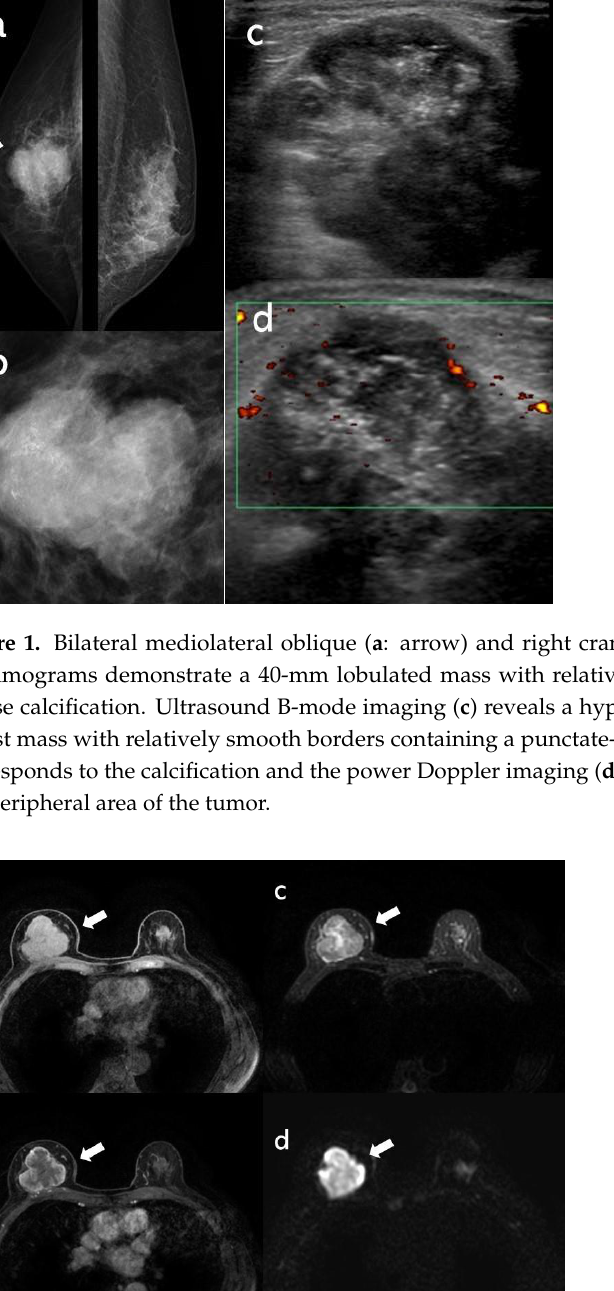
Figure 2. Magnetic resonance imaging shows a lobulated mass on the T1-weighted image (TWI) ( a : arrow) with strong contrast mainly seen on the periphery on contrast-enhanced T1WI ( b : arrow), a high signal in the center on T2WI ( c : arrow) and a high signal in the peripheral on diffusion-weighted images ( d : arrow).